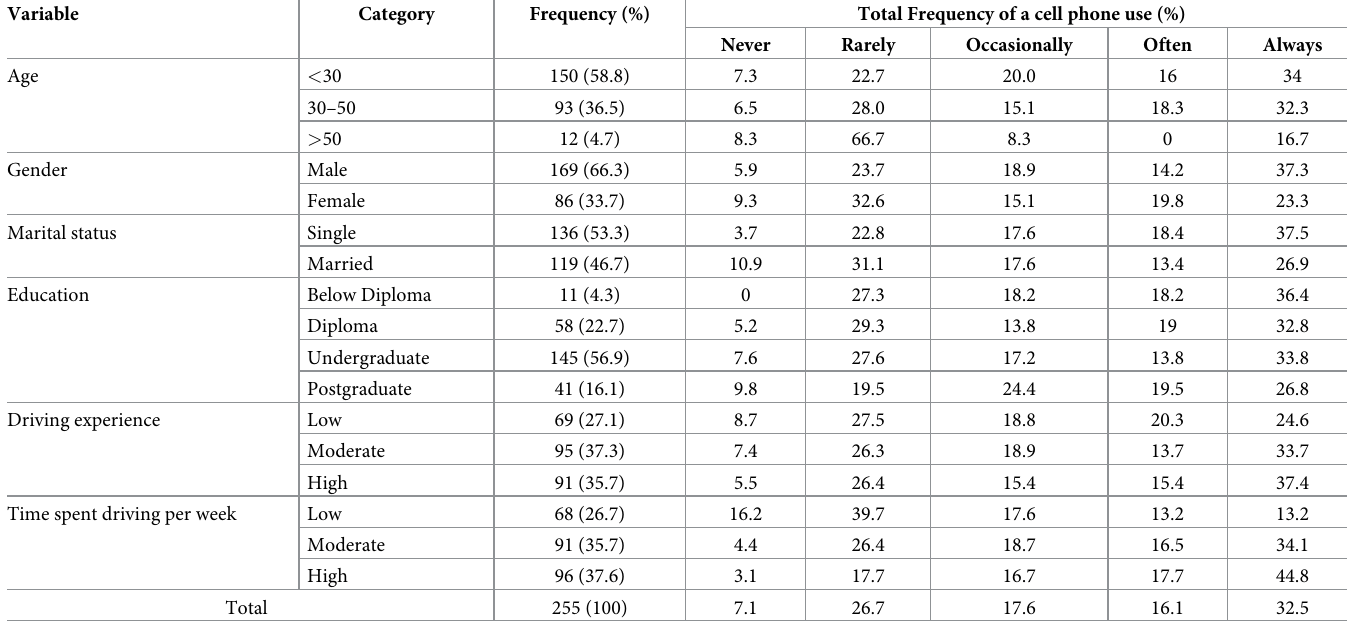
Table 1. Demographics and the total frequencies of a cell phone